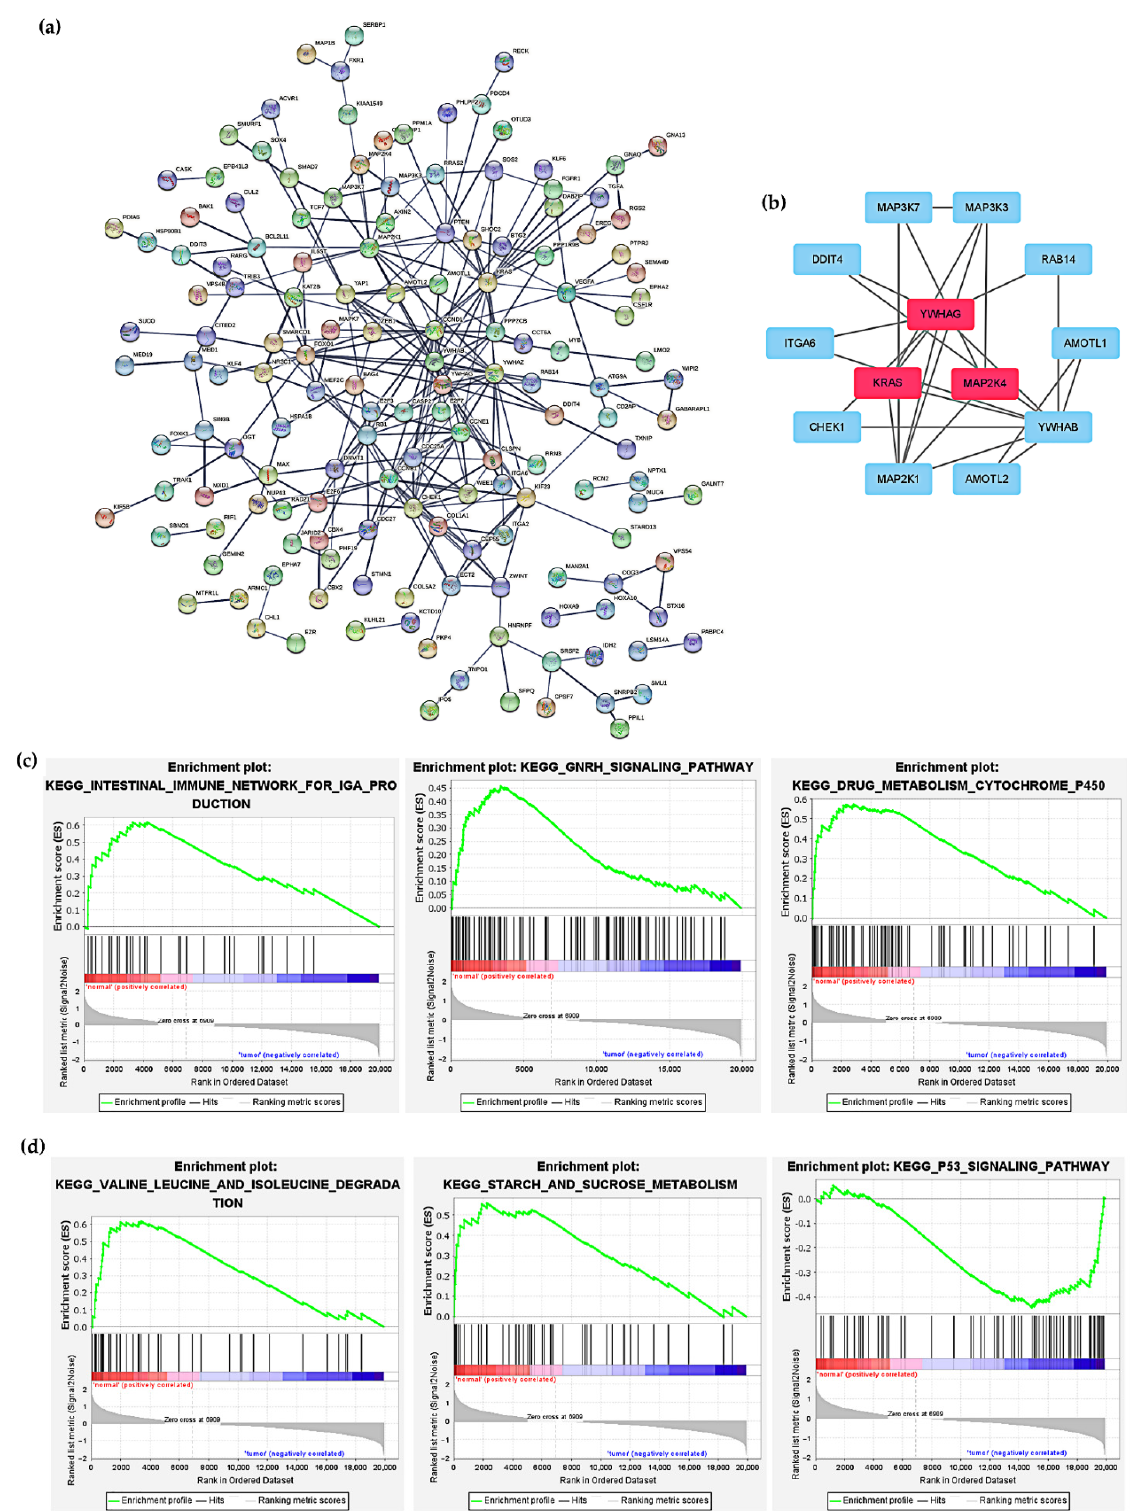
Figure 9. Construction of protein–protein interaction (PPI) network and gene set enrichment analysis. ( a ) PPI network was constructed with 325 targeting mRNAs. ( b ) PPI network of 13 genes were obtained by Cytoscape, among which YWHAG, KRAS, MAP2K4 were core genes. ( c , d ) Potential signaling pathways for targeting mRNAs revealed by GSEA analysis.